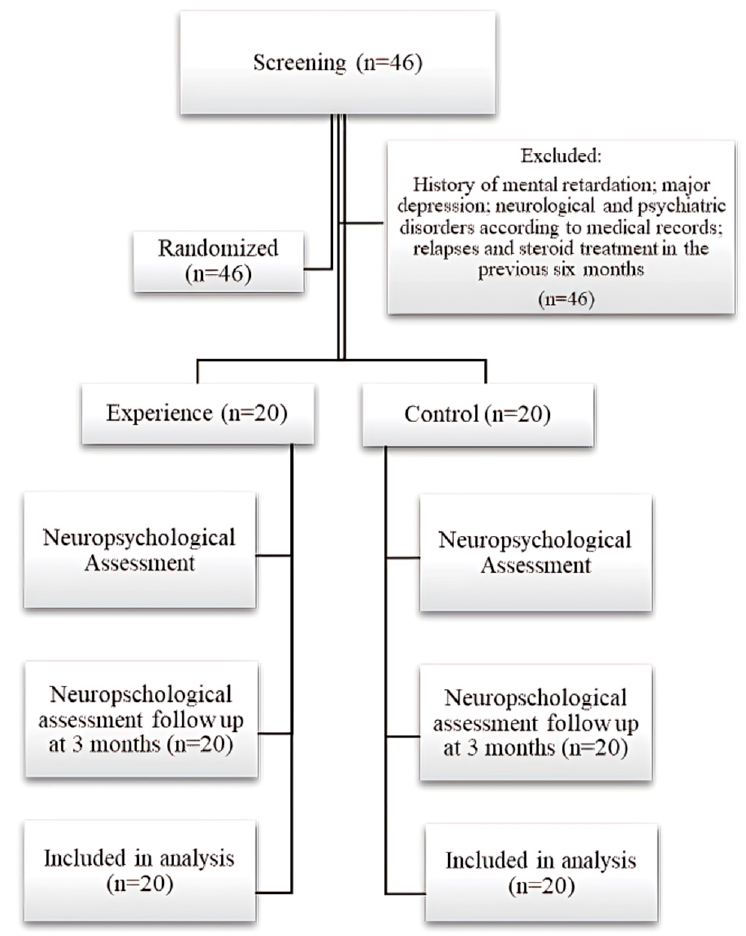
Figure 1. Flowchart of intervention.